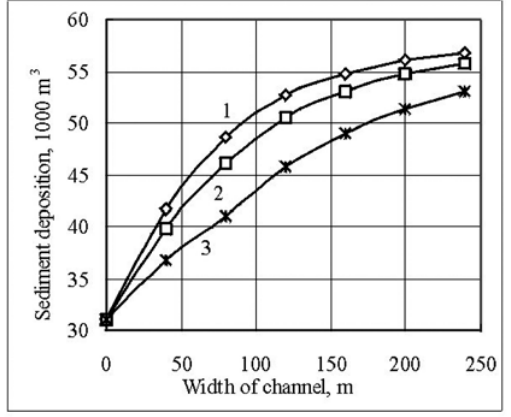
Fig. 8. Dependence of average amount of sediment, settled during one year, on the width of channel, when the depth of channel is: 1 – 3.0 m; 2 – 2.5 m; 3 – 2.0